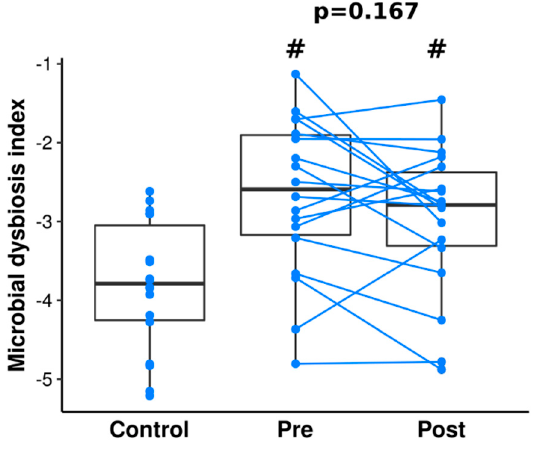
Figure 6. Microbial dysbiosis index of the control and patients with CD pre- and post-IFX therapy. Statistically significant values, after Benjamini-Hochberg correction, between control and other groups are represented as “#”. p -values from a paired t-test are shown above the bars of the patients with CD. Lines connect paired samples from the same individual.